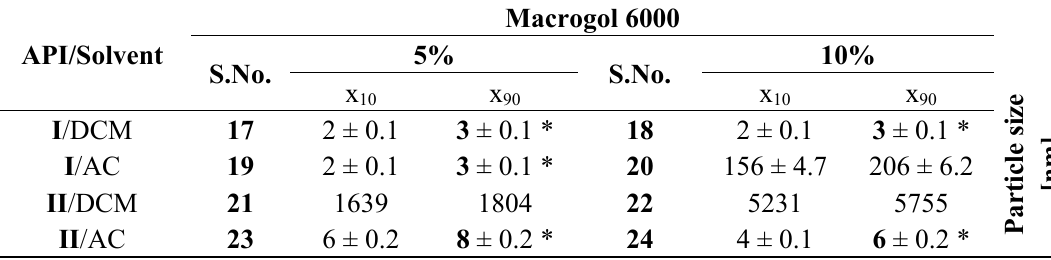
Table 3. Particle size (x , x [nm]) of APIs I , II and concentration [%] of macrogol 6000 10 90 in dichloromethane (DCM) or acetone (AC). All the presented results are reported as the medium value of four independent measurements. The results of nano-size samples are expressed as the mean ± SD ( n = 4 measurements). The SDs of micro-size samples are not indicated due to the measurability range of Nanophox. Samples that contained nanoparticles <200 nm are bolded; nanoparticles <10 nm are indicated by asterisk. (S.No. = sample number).